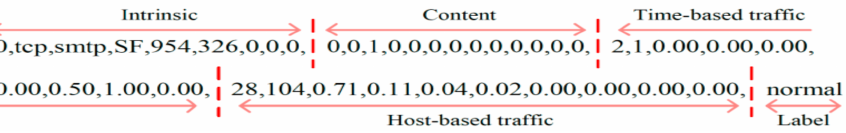
Figure 1. Characteristic of the NSL_KDD traffic sample.